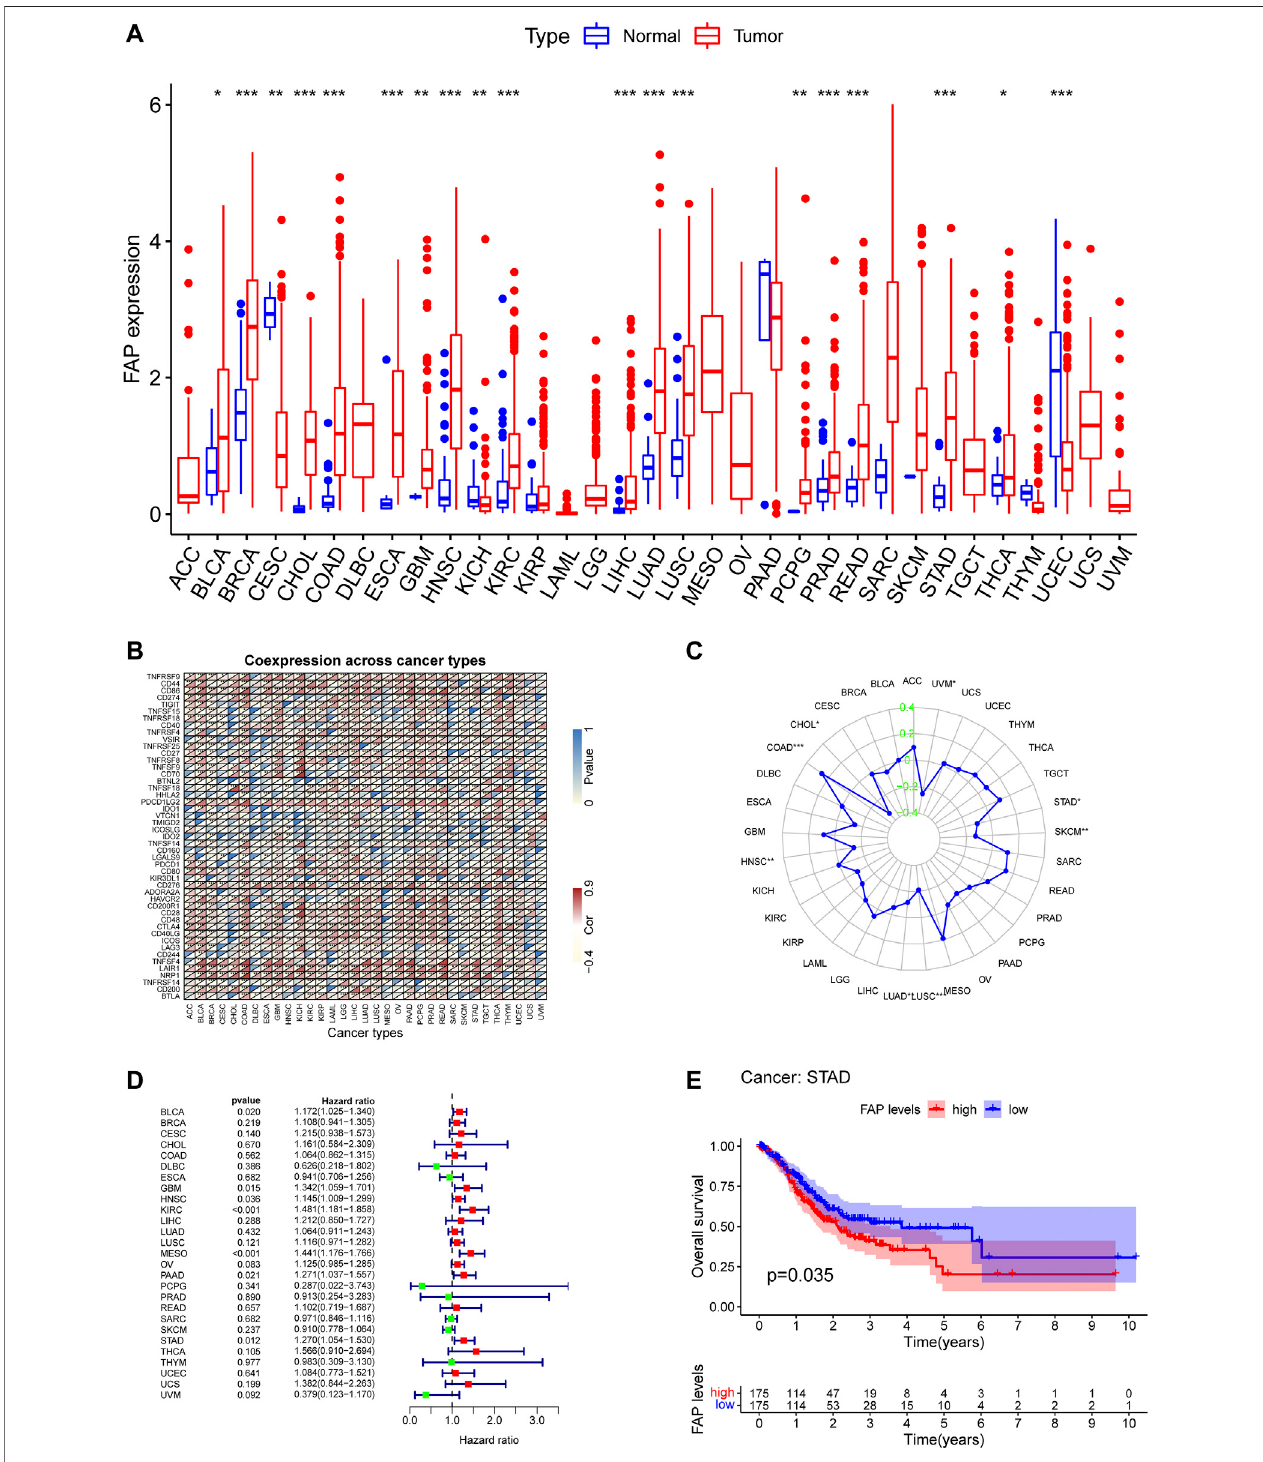
FIGURE 1 | High FAP expression infers poor prognosis for STAD. (A) FAP expression levels in tumors compared to normal tissues in 33 cancers; * p < 0.05, ** p < 0.01, *** p < 0.001. (B) Correlations between FAP expression and immune checkpoint gene expression in 33 cancers; * p < 0.05, ** p < 0.01, *** p < 0.001. (C) Results of correlation analysis between FAP expression in pan-cancer and MSI described using Spearman ’ s rank correlation coef fi cient. (D) Univariate Cox analysis of FAP shown by a forest plot. A hazard ratio of > 1 represented risk factors for survival and a hazard ratio of < 1 represented protective factors for survival. The full version can be accessed in supplementary fi gure. (E) Kaplan – Meier plots of FAP in STAD. Patients were divided into high and low FAP expression groups based on the median FAP expression level.